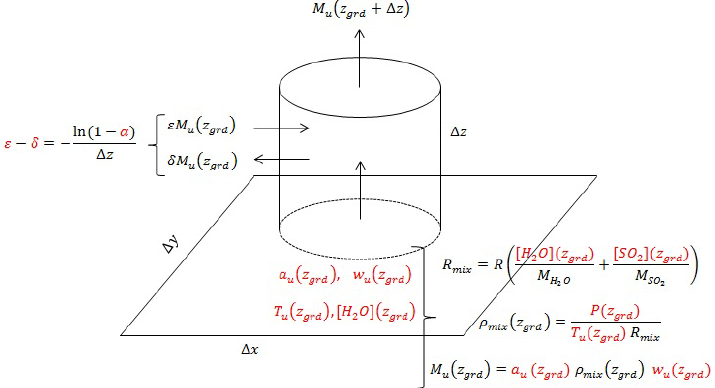
Figure 3. Figure displaying the input data, the mass flux at ground level ( z grd ), and the mass flux at level z grd + (cid:49)z after the incorporation of environmental air mass. The input variables of the model are highlighted in